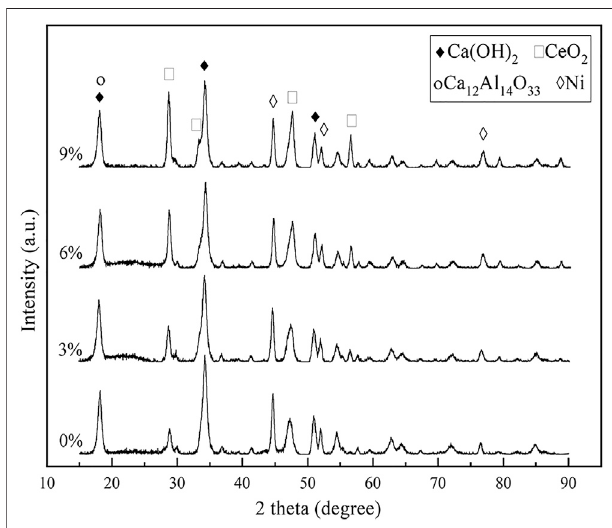
FIGURE 3 | XRD patterns of Ce-modi fi ed catalysts with different doping mass proportions.